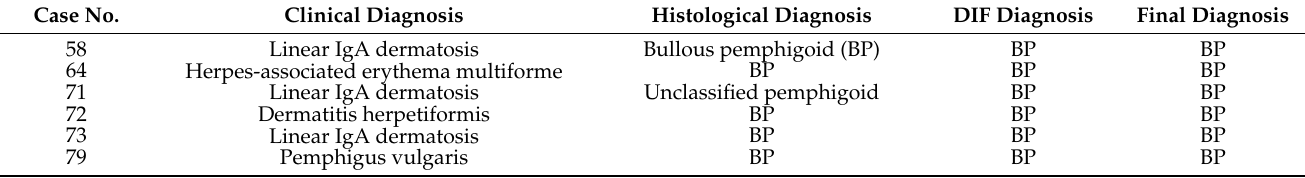
Table 8. Discordant Findings Between the Clinical And Direct Immunofluorescence Stains For Subepidermal